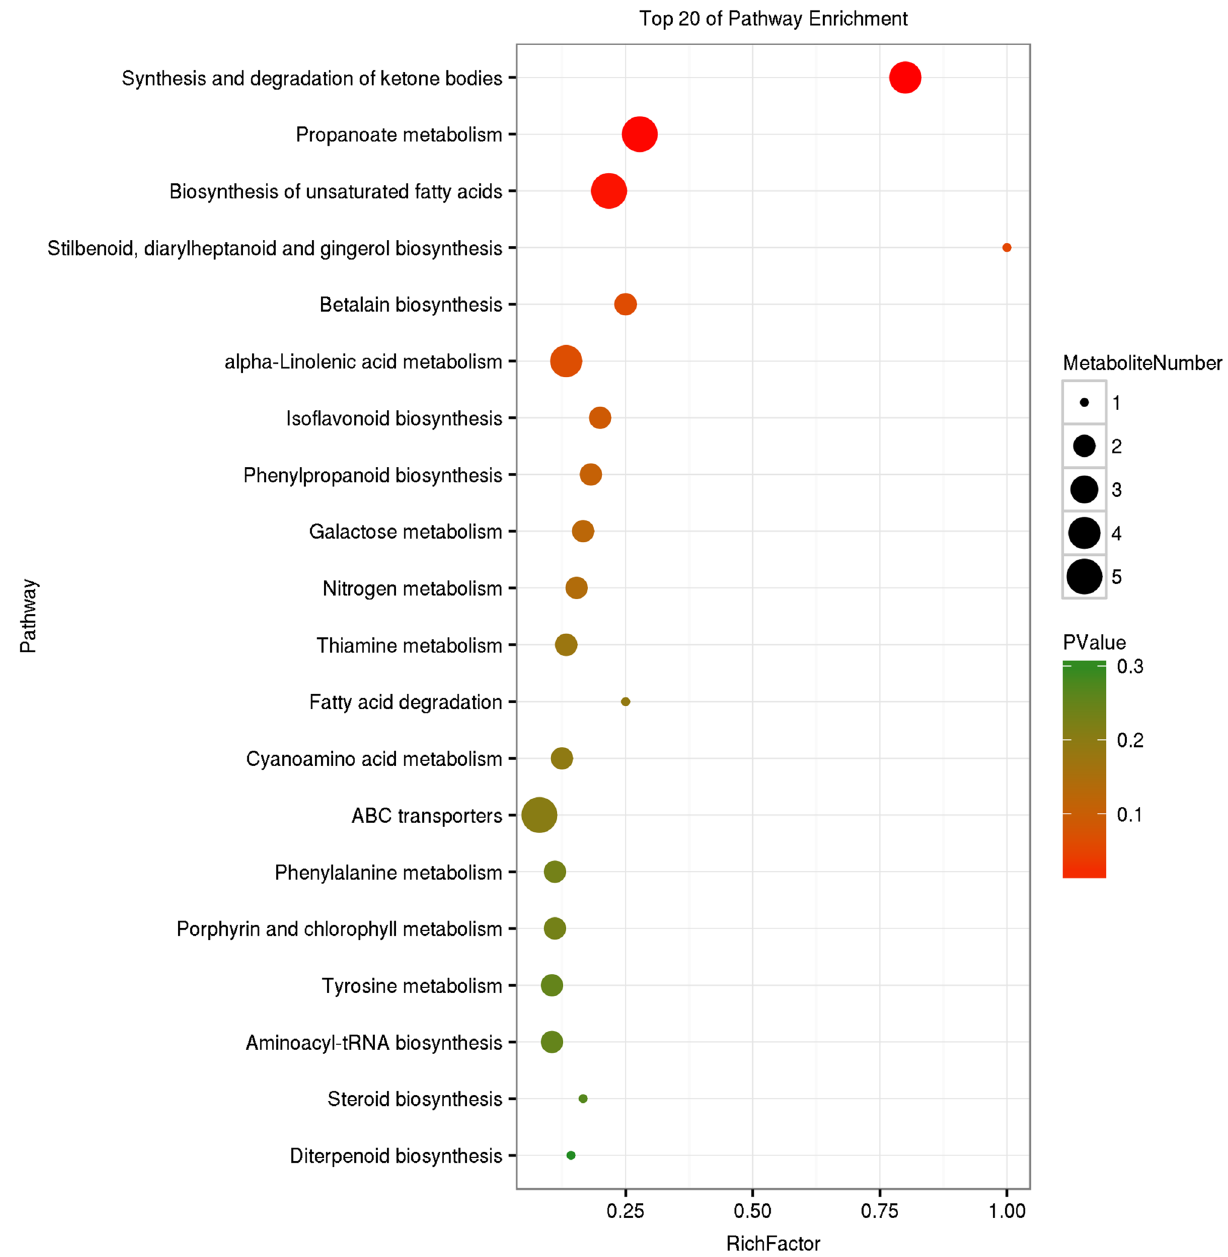
Figure 3. KEGG enrichment map of differential metabolite of two strains at 34 d culture. The vertical axis represents pathway entries, and Rich Factor on the horizontal axis refers to the ratio of the number of differential metabolites in the pathway to the total number of metabolites in the pathway. Higher Rich Factor values indicate a higher degree of enrichment. The size of the circle corresponds to the number of enriched metabolites, with a larger circle indicating more genes. P values range from 0 to 1, corresponding to the gradual change from red to green, with red being zero and indicating more significant enrichment. The figure is plotted with the first 20 pathways of P values from smallest to